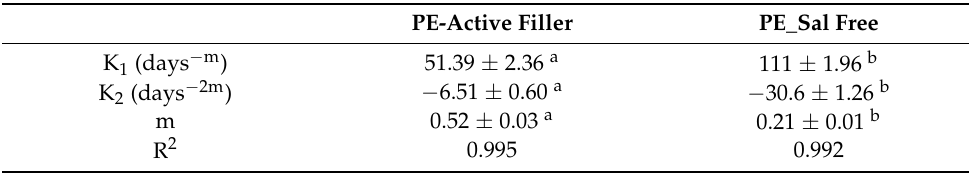
Table 1. Peppas –Sahlin’s model parameters obtained from equation 1. Table 1. Peppas–Sahlin’s model parameters obtained from Equation